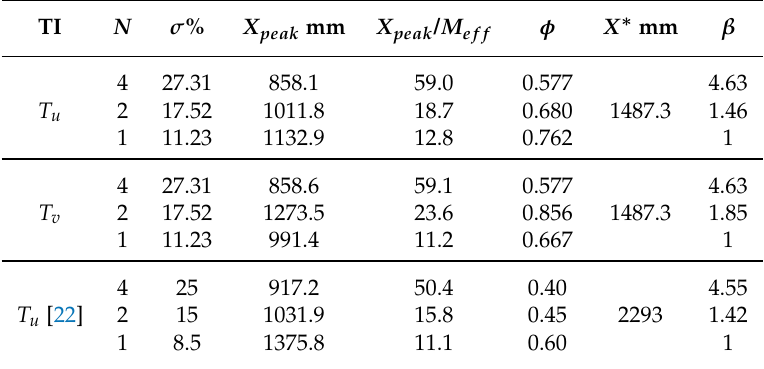
Table 2. Wake interaction length scales of the fractal square grids, FG1, FG2 and FG4. TI N σ % X peak